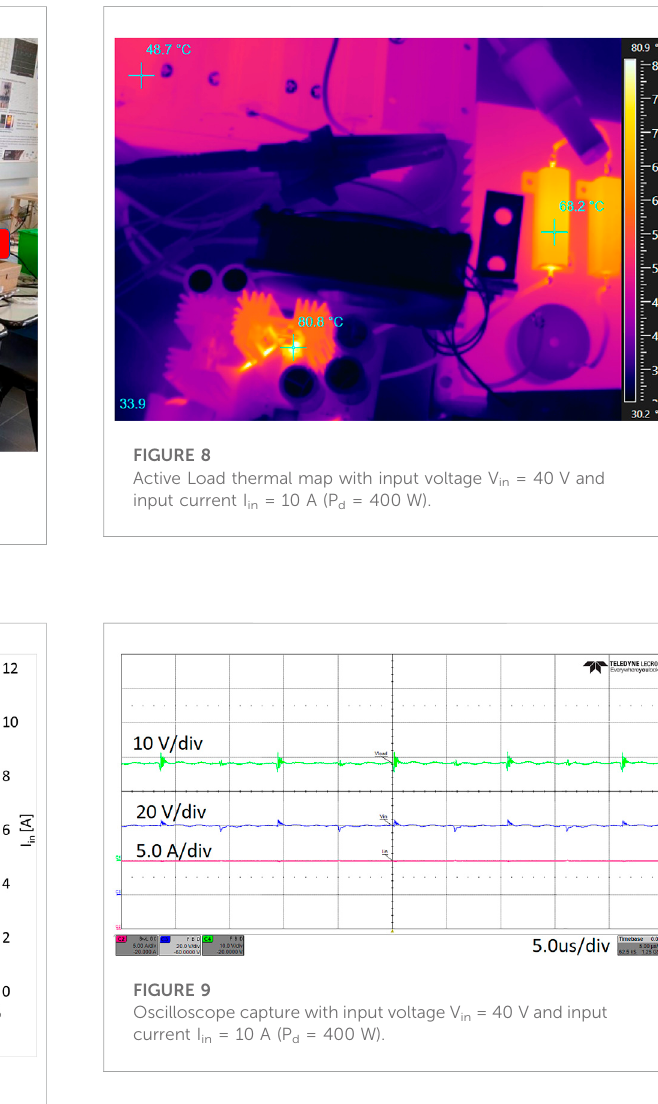
FIGURE 7 Total input absorbed power and input current versus the duty-cycle at fi xed input voltage V in = 24 V.